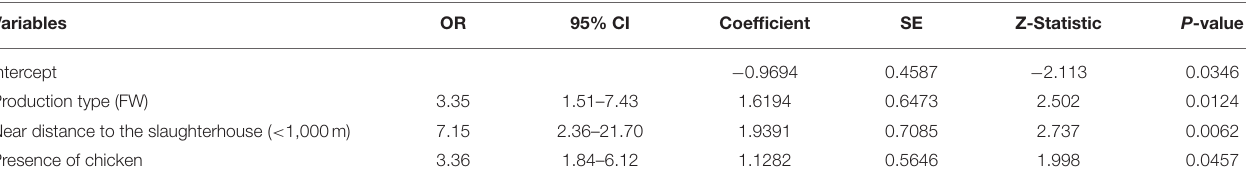
TABLE 2 | Results of the final multivariate model of risk factors associated with Porcine epidemic diarrhea virus in a case–control study on northern Vietnamese pig farms in 2018. Variables OR 95% CI Coefficient SE